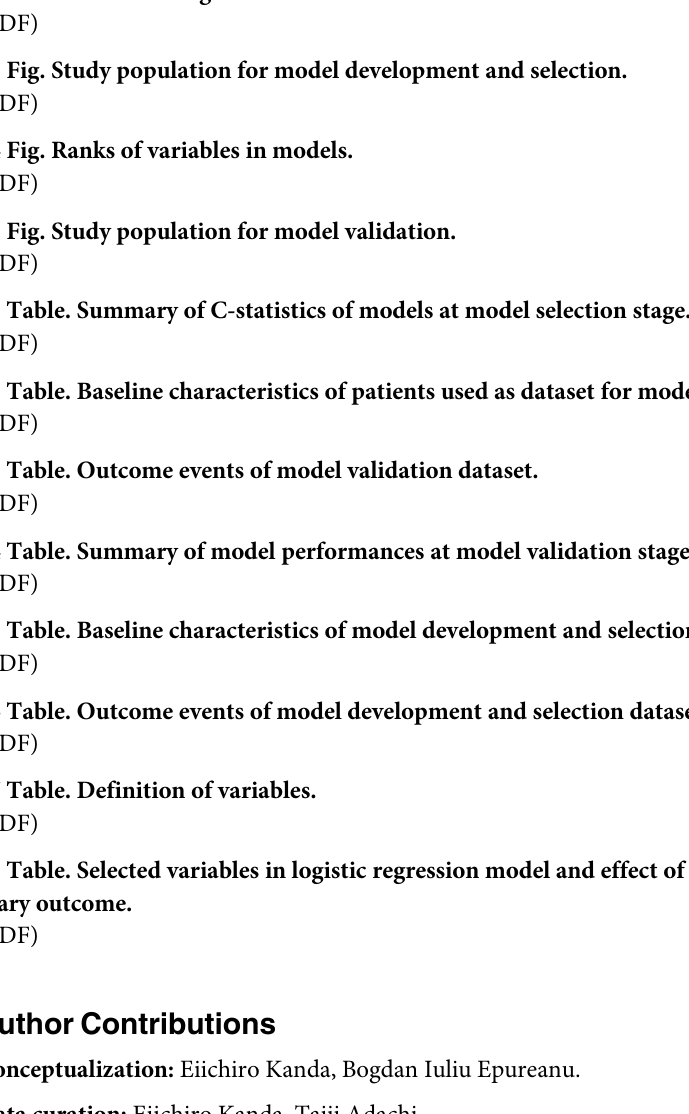
S2 Fig. C-statistics of models for prediction of primary outcome over 1 year in subclasses at model selection stage. S3 Fig. Study population for model development and selection. S4 Fig. Ranks of variables in models. S5 Fig. Study population for model validation. (PDF) S1 Table. Summary of C-statistics of models at model selection stage. (PDF) S2 Table. Baseline characteristics of patients used as dataset for model validation. (PDF) S3 Table. Outcome events of model validation dataset. (PDF) S4 Table. Summary of model performances at model validation stage. (PDF) S5 Table. Baseline characteristics of model development and selection datasets. (PDF) S6 Table. Outcome events of model development and selection datasets. (PDF) S7 Table. Definition of variables. S8 Table. Selected variables in logistic regression model and effect of each variable on pri- mary